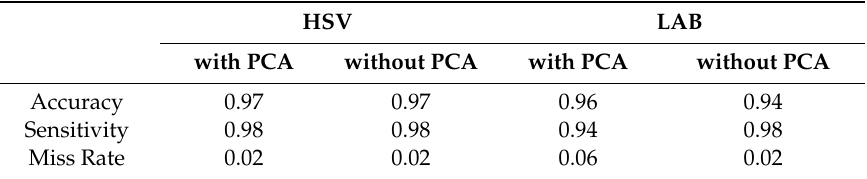
Table 2. Deep Random Forest.